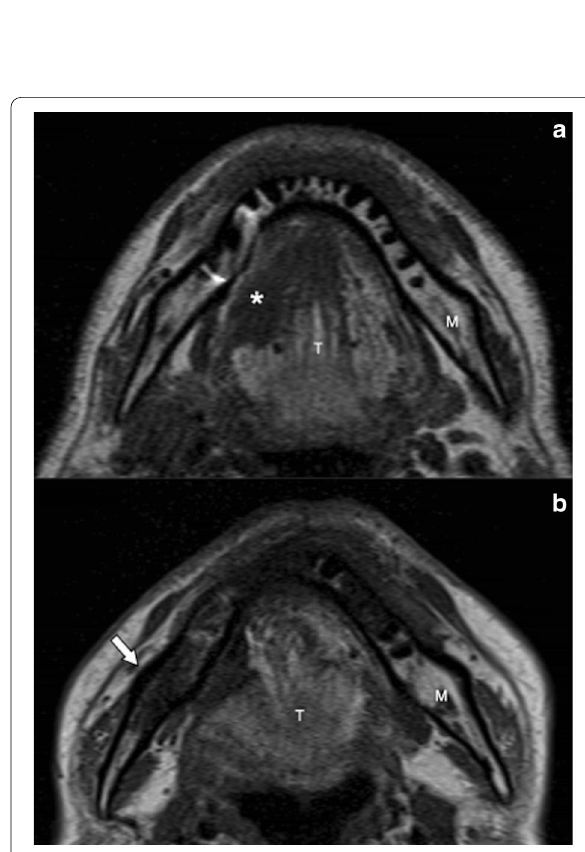
Fig. 7 Osseous sclerosis of the right ramus of the mandible (arrow) in a 44-year-old man 5 years after right hemiglossopelvectomy followed by adjuvant ChT/RT for a carcinoma of the right border of the tongue. Pretreatment axial T1-weighted ( a ) MR image shows a lesion of the right border of the tongue (asterisk) and normal signal intensity of the right ramus of the mandible. Post-treatment axial T1-weighted ( b ) MR image shows the surgery outcome and diffuse hypointense signal of the spongiosa of the right ramus of the mandible (arrow). M, mandible; T,